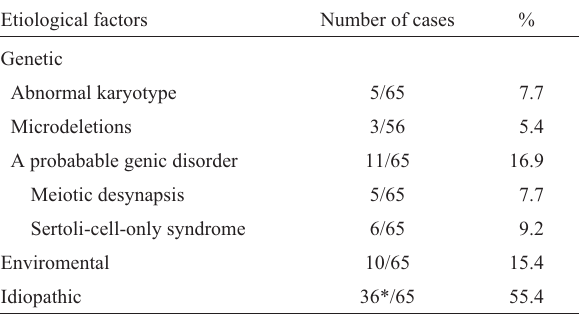
Table 5 - Etiological factors diagnosed in the infertile